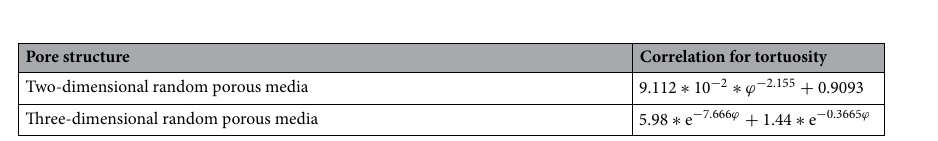
Table 4. Empirical tortuosity–porosity relations for porous media at two and three-dimensional pore structures.